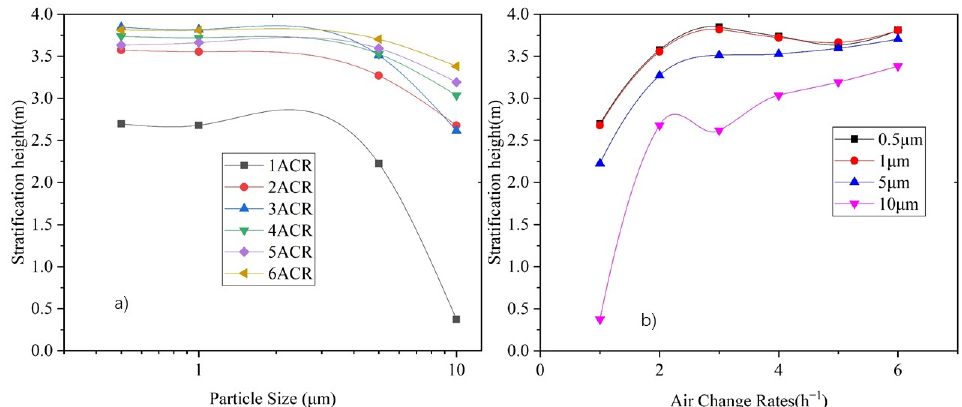
Figure 13. Variation of stratification height under 1–6 ACR for each particle size. ( a ) Relationship between stratification height and particle size, and ( b ) relationship between stratification height and air change rate.